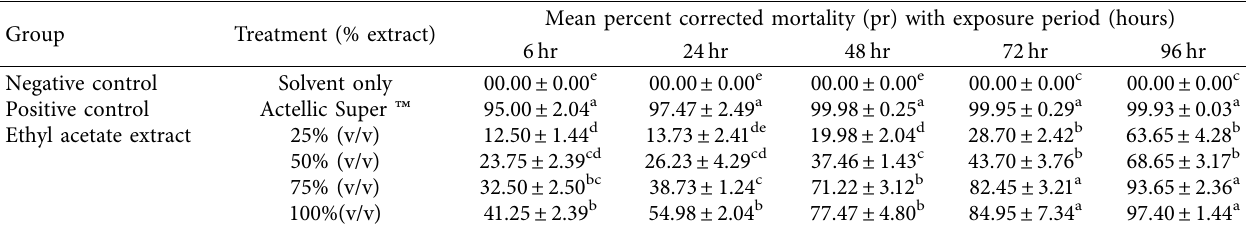
Table 8: Contact toxicity effects of ethyl acetate leaf extracts of V. lasiopus against S. zeamais . Group Positive control